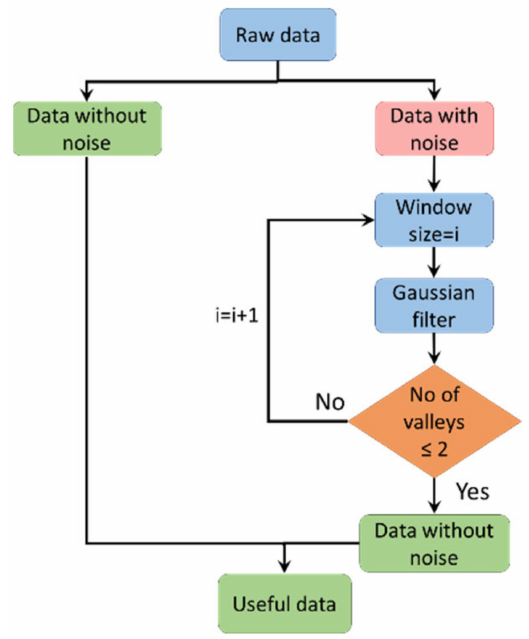
Figure 3. Workflow of data-denoising